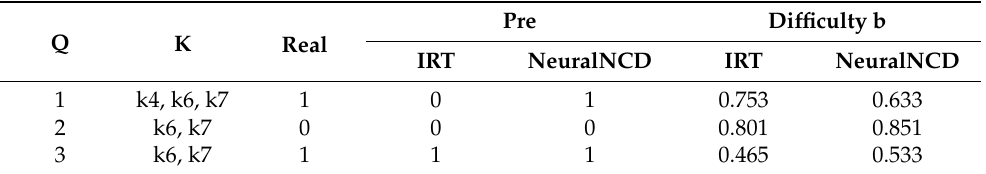
Figure 3. AUC scores for NeuralNCDA and NeuralNCD training and validation on datasets ( a ) ASSIST2009, ( b ) FrcSub.